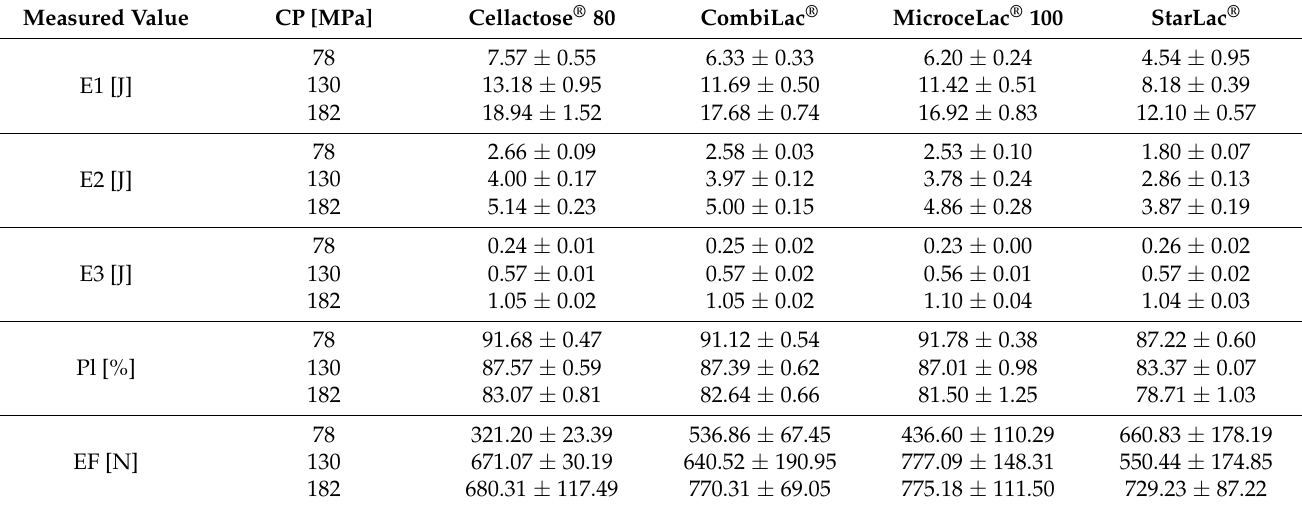
Table 3. Energetic parameters of compression, plasticity, and ejection